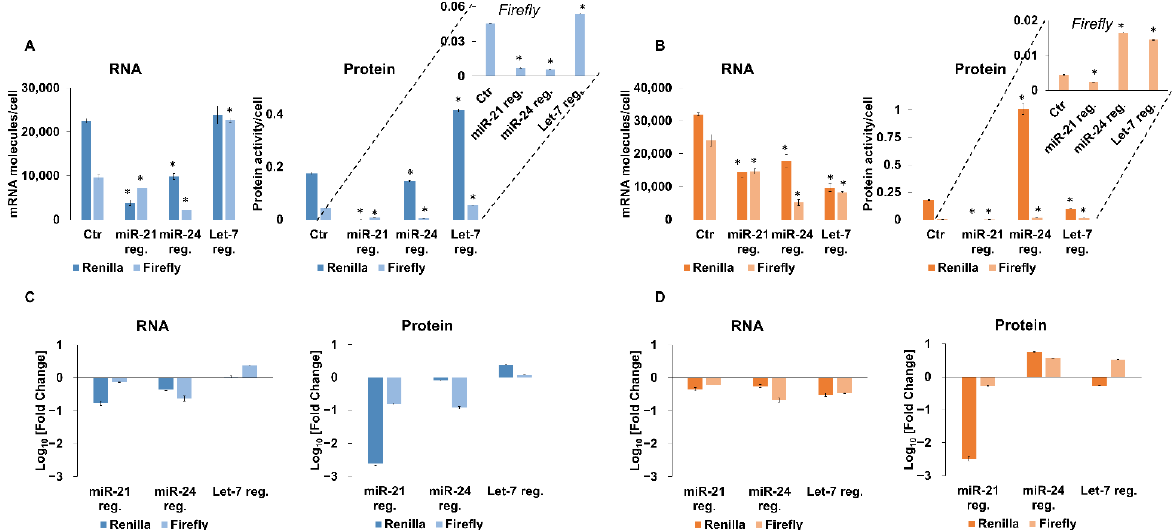
Figure 2. Expression of Renilla and firefly luciferase reporter genes transfected into HCT116 ( A , C ) or Me45 ( B , D ) cells. ( A , B ) show the levels of control and miRNA-targeted Renilla , and of non-targeted co-transfected firefly luciferase mRNA transcripts (molecules/cell) and proteins (activity/cell) in HCT116 and Me45 cells, respectively. ( C , D ) show fold changes in the levels of luciferase transcripts and proteins resulting from the presence of miRNA targets in the Renilla gene. The results are means from three independent experiments performed on the same cell populations and vertical bars show standard deviation. * indicate the significance with p -value < 0.05 compared to control transcripts.